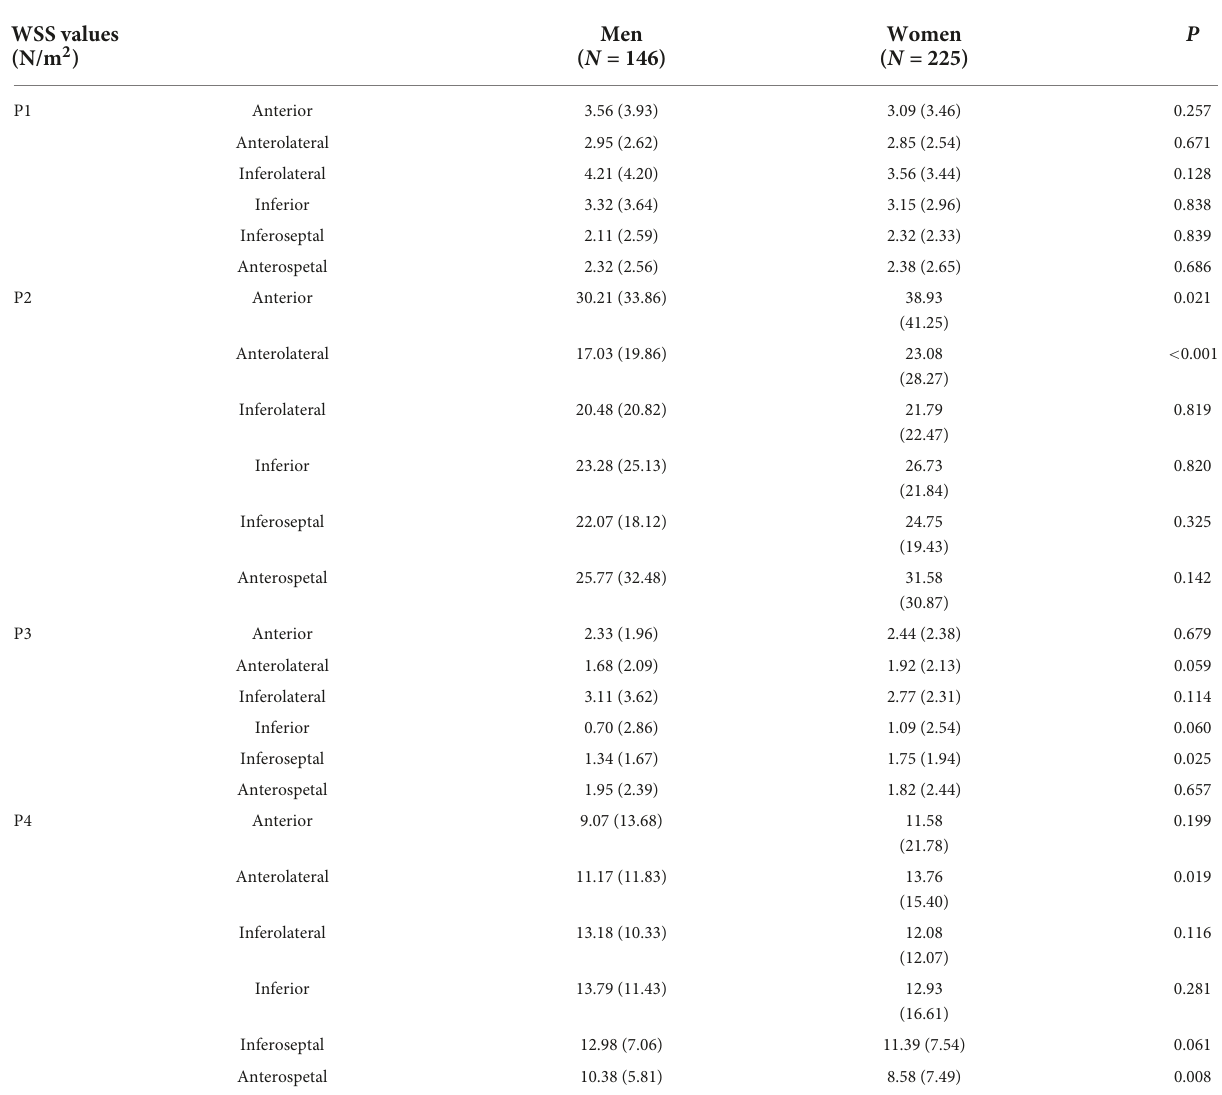
TABLE 3 Differences in LV WSS values between men and women at diastolic